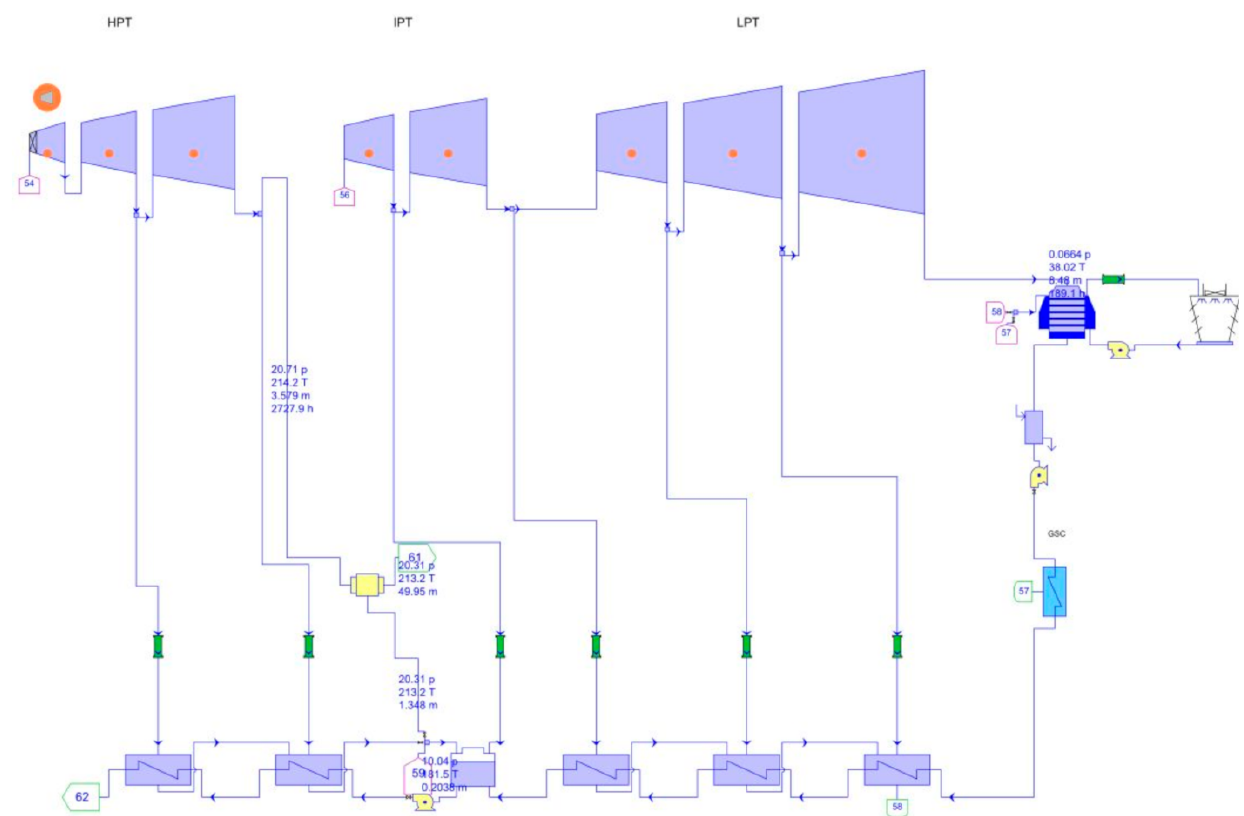
Figure 7. Thermoflex diagram for a 50 MWe Rankine